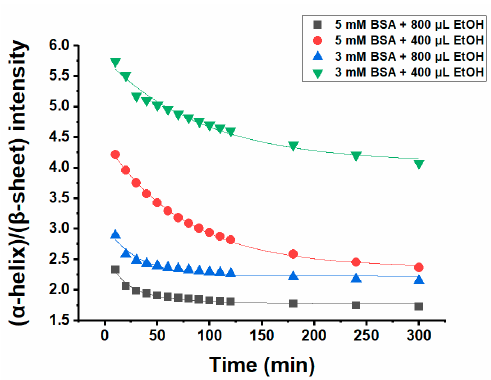
Figure 4. I( α -helix)/I( β -sheet) as a function of time for 1000 µL 5 mM or 3 mM BSA precursor solutions with 800 µL or 400 µL ethanol at 37 °C. The solid lines are fitted curved.